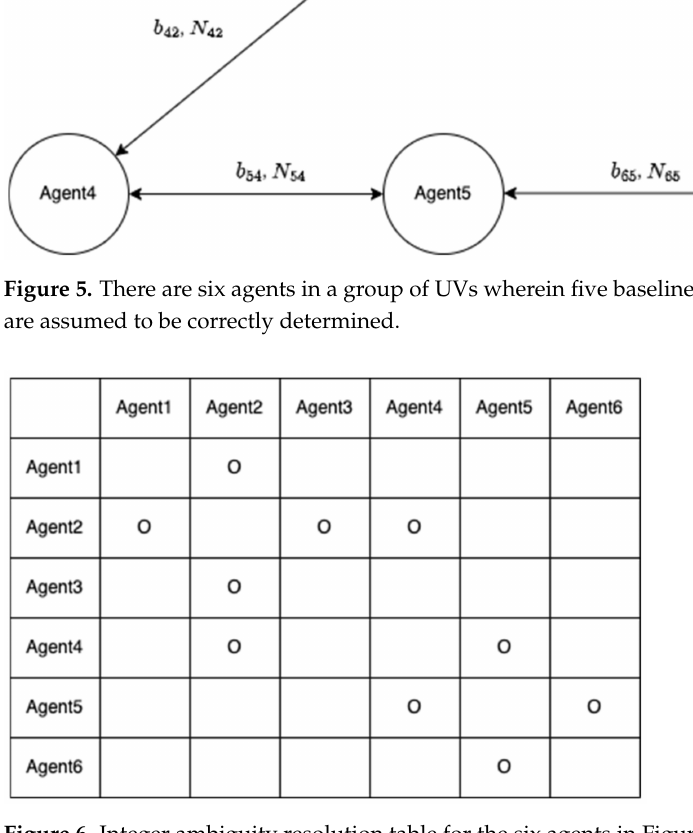
Figure 6. Integer ambiguity resolution table for the six agents in Figure